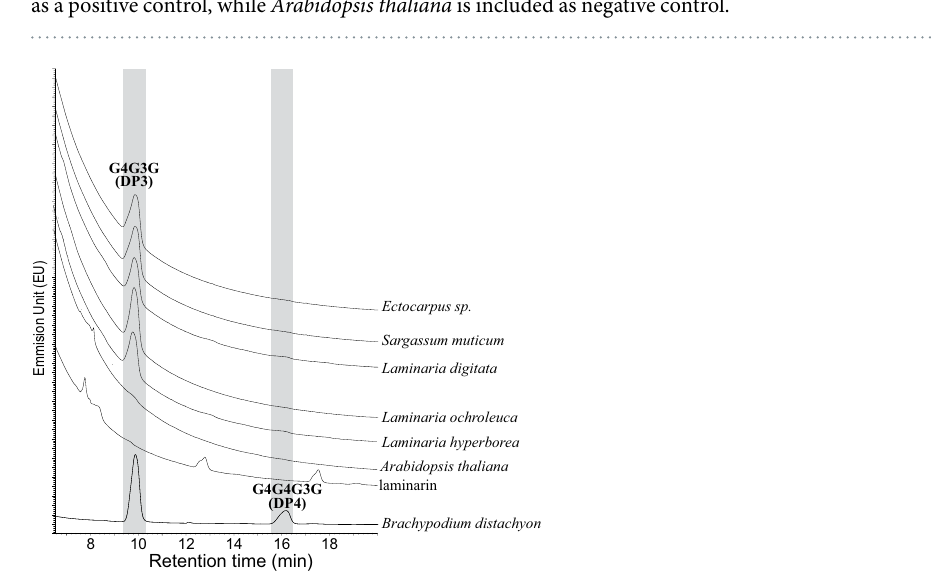
Figure 2. Deletion of MLG epitopes from glycan arrays by enzymatic treatment. Glycan arrays were treated with buffer only or with either a lichenase (10 µ g/ml) or a laminarinase (7.4 µ g/ml) for 5 min before probing with the anti-mixed linkage glucan (MLG) and anti-alginates (LM7) antibodies. Brachypodium dystachion is included as a positive control, while Arabidopsis thaliana is included as negative control.